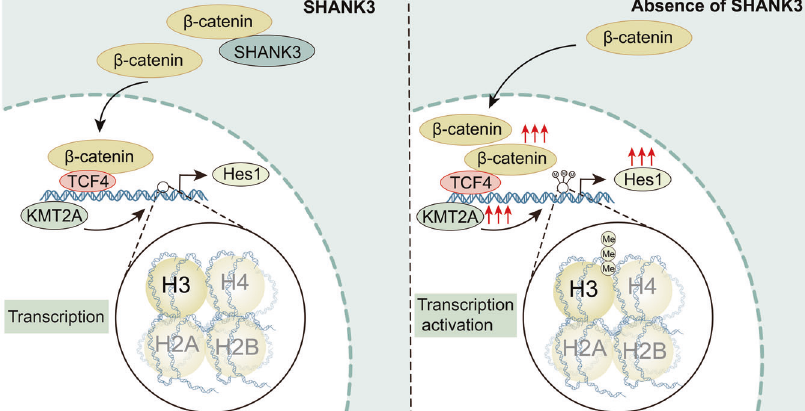
Fig. 8 Schematic diagram illustrating the effects of SHANK3 on quiescent NSC activity. SHANK3 regulates KMT2A and Hes1 by mediating the nuclear translocation of β -catenin, thereby affecting the activity of quiescent